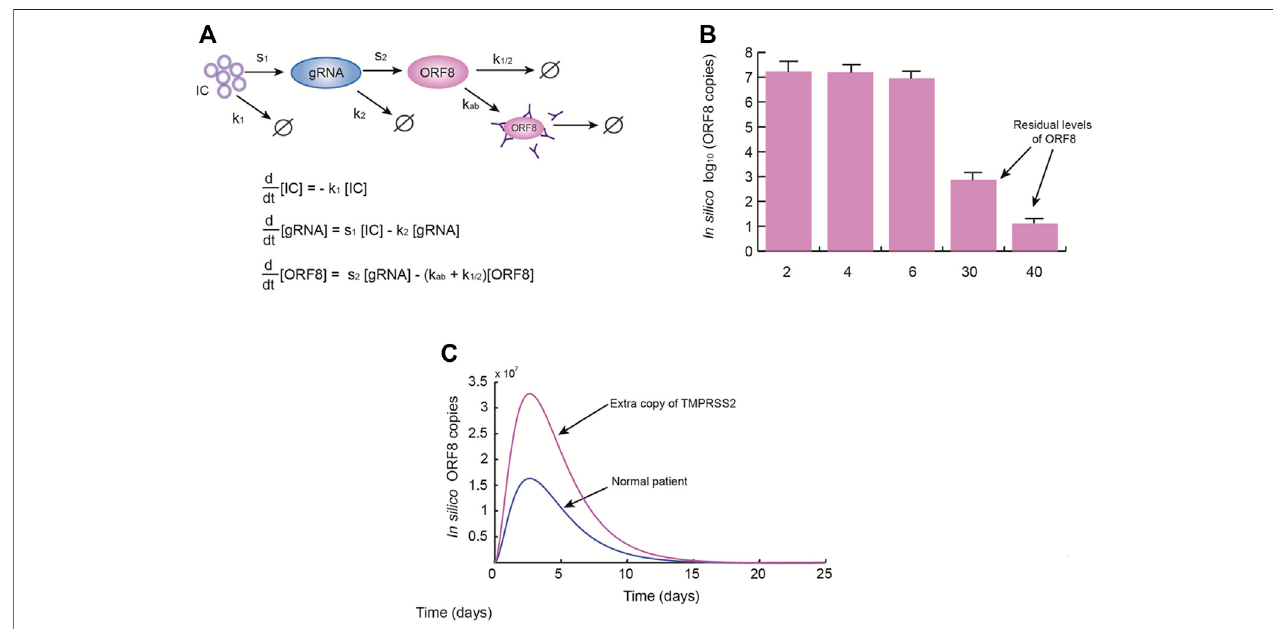
FIGURE1| Downsyndromepatients havehigherlevelsofORF8duringSARS-COV-2infection. (A) OncetheSARS-CoV-2ACE2-Spikecomplexesenterthecells ( IC ), the production of genomic RNA (gRNA) originates ORF8 antigens by several editing steps. These copies of ORF8 may be naturally degraded or eliminated by antibodies. (A) The simpli fi ed model of ORF8 production used in this work. In the model k 1 = 0.4 days − 1 , s 1 = 100 days − 1 , k 2 = 1.3 days − 1 , s 2 = 20 days − 1 , k ab = 0.3 days − 1 ,and k 1/2 = 0.5 days − 1 . (B) MeanlevelsofORF8obtainedfromthemodelsimulationsat2,4,6,30,and40 days.TheseresultssuggestthatORF8 persists even if thepatient isdischarged 15 days after viralonset. (C) Effect ofthepresence ofanextra copy ofTMPRSS2.Thesesimulations show thatanextracopy of TMPRSS2 gene is able to dramatically increase systemic levels of ORF8, which implies that Down syndrome patients are more susceptible to medical complications produced by